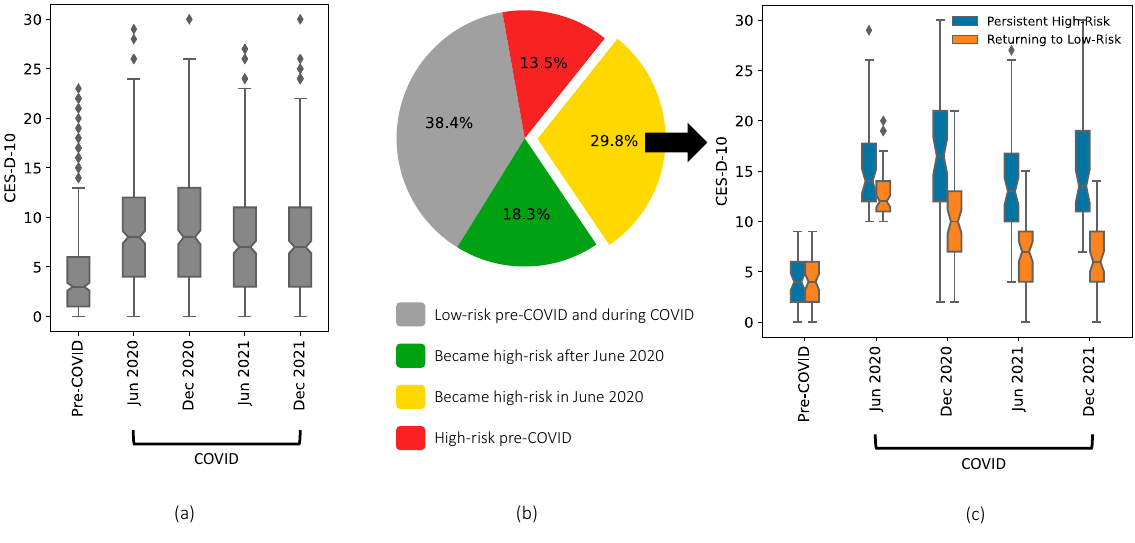
Figure 1. ( a ) The trajectory of depressive symptoms from pre-COVID-19 to December 2021 of 399 NCANDA participants (age 18.0 to 28.6 years in June 2020). The CES-D-10 score increased significantly in 2020 compared to pre-COVID-19 visits ( p < 0.001) and then significantly declined in 2021 ( p < 0.001). ( b ) Participants grouped by the time of becoming high-risk (CES-D-10 ≥ 10). ( c ) A total of 51% of the participants who became high-risk in June 2020 returned to the low-risk level in 2021, while the remaining participants stayed